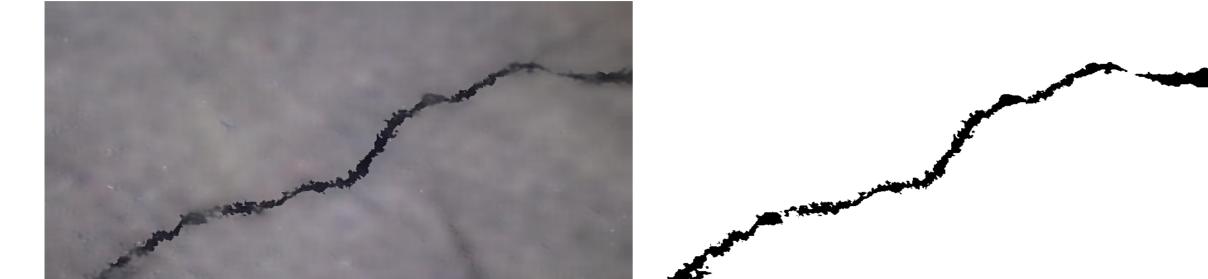
Figure 6. Otsu thresholding method processing results.